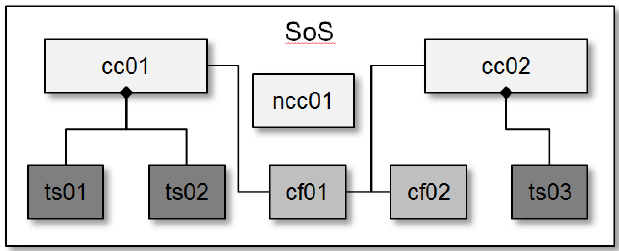
Figure 3. Architecture with connection (e.g. cc01 − cf01 ) and containment (e.g. cc01 − ts01 ) relations.